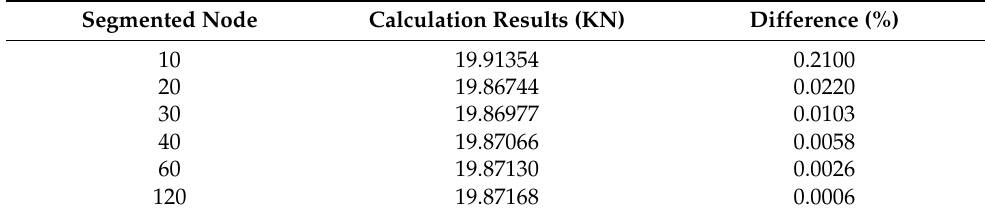
Figure 9. The catenary shape. Table 1. The comparison between calculation results and theoretical results.